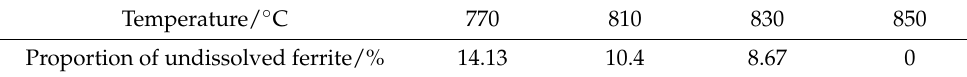
Figure 6. Microstructure morphology of the quenched specimens in the sub-temperature region. ( a ) 770 °C, ( b ) 810 °C, ( c ) 830 °C, and ( d ) 850 °C. Table 4. Statistics of ferrite ratios in different sub-temperature ranges of Q state. Temperature/ ◦ C 770 810 830 850 Proportion of undissolved ferrite/%